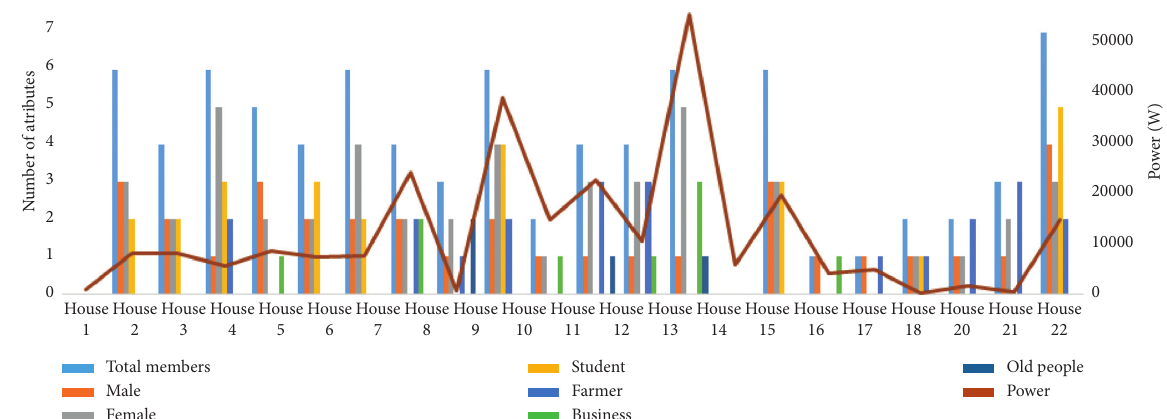
Figure 11: Relationship between power usage and different demographic attributes.